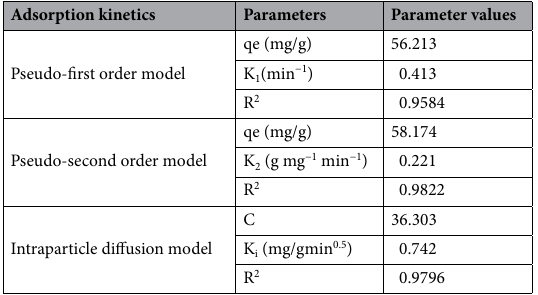
Table 5. Kinetic parameters of As(V) adsorption on amino-MIL-68(Al).